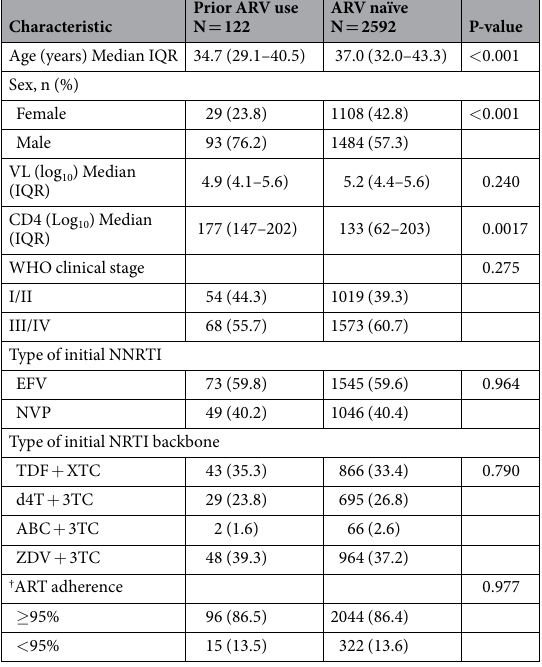
Table 1. Baseline characteristics of patients with and without prior ARV use. Data are presented as n (%), unless stated otherwise. 3TC, lamivudine; ABC, abacavir; ART, antiretroviral therapy; d4T, stavudine; EFV, efavirenz; NVP, nevirapine; TDF, tenofovir; VL: viral load; XTC, lamivudine or emtricitabine; ZDV, zidovudine. † Mean adherence measured as 30-day self-reported adherence over 12